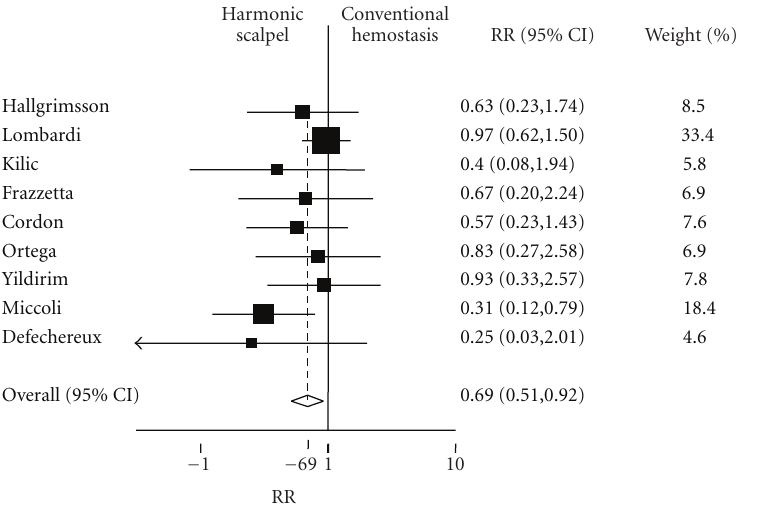
Figure 5: Forest plot depicting individual and pooled risk ratios (RRs) with 95% confidence intervals (CIs) for transient postoperative